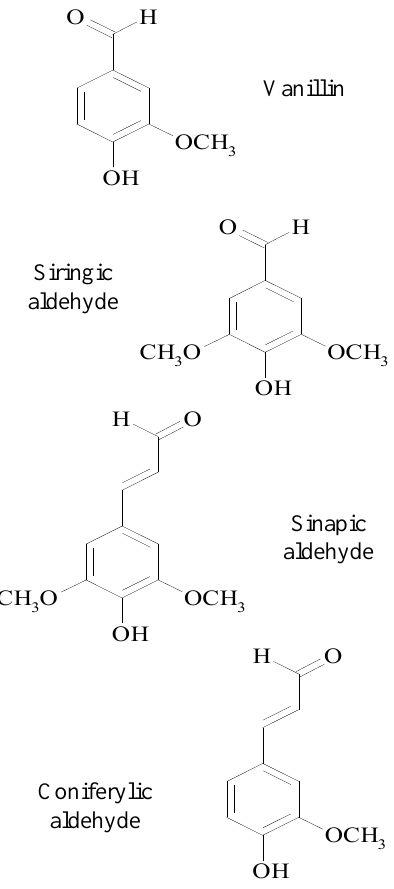
Fig. 1. Characteristic aromatic aldehydes of cognac